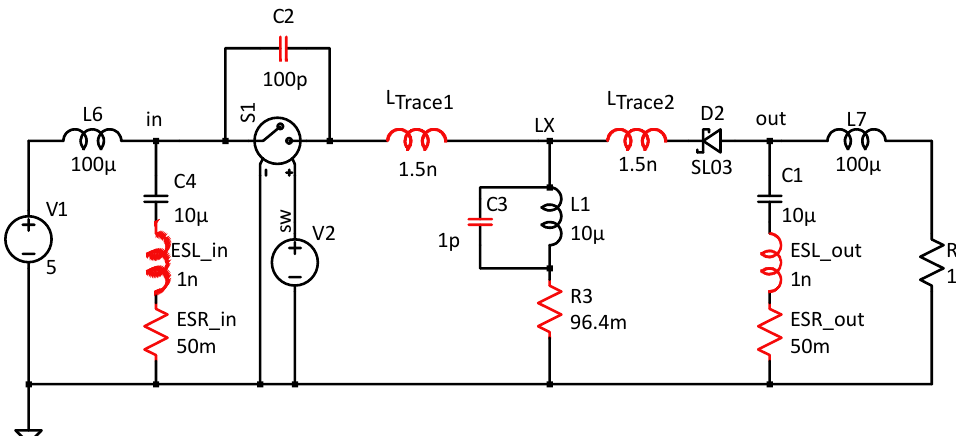
Figure 5. Simulation model including